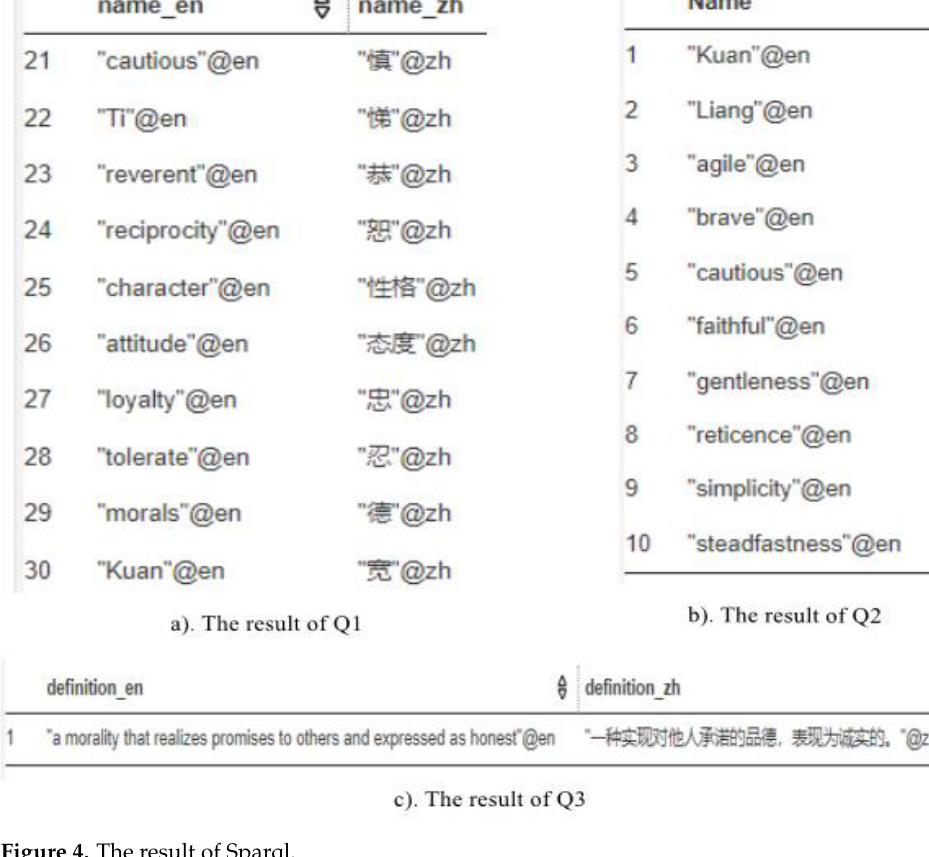
Figure 4. The result of